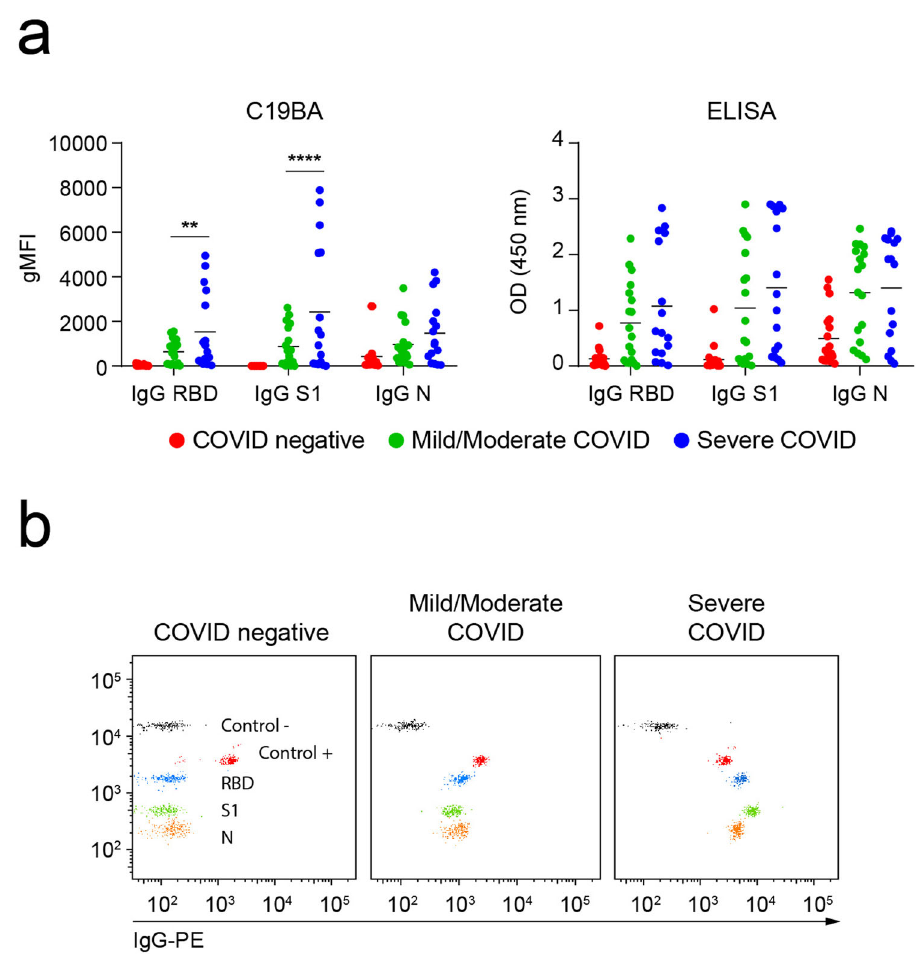
Fig. 5 Severe Covid-19 patients present higher levels of anti-spike IgG antibodies compared to moderate Covid-19 patients. a gMFI values obtained by C19BA (left) and OD values obtained by ELISA (right) corresponding to levels of IgG against RBD, S1, and N for the indicated cohorts. b Representative dot plots obtained by C19BA showing IgG levels for COVID negative ( n = 18), mild/moderate COVID ( n = 18), and severe COVID serums ( n = 16) obtained from PCR + individuals at the time of hospital admission. Statistical analyses were performed using two-way ANOVA. Asterisks represent p values (**** p < 0.0001, * p < 0.05). Horizontal lines represent median